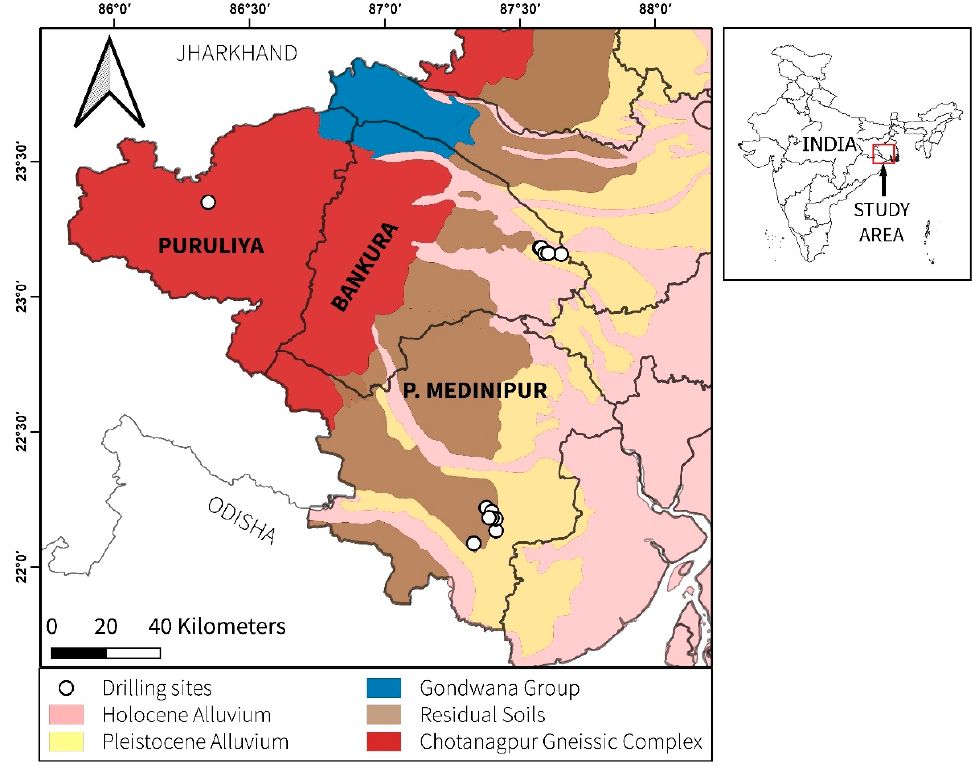
Figure 1. Geological map of the study area along with the locations of the drilling